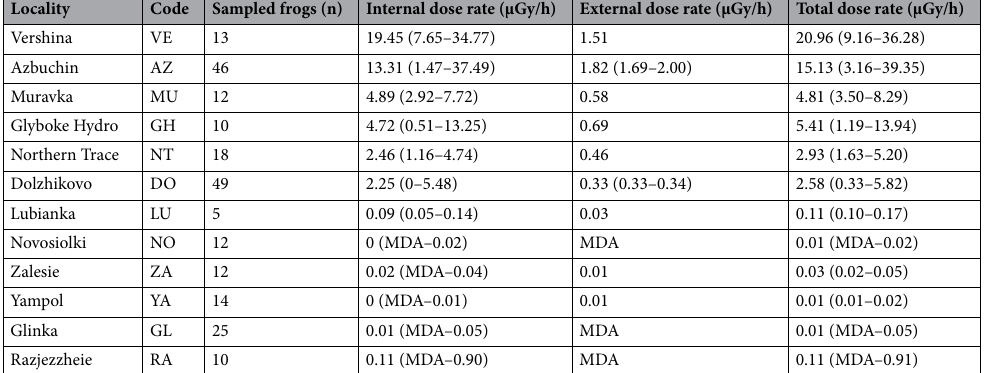
Table 2. Dose rates of breeding Eastern tree frog ( Hyla orientalis ) males captured within the Chernobyl Exclusion Zone (2016–2018). Data presented as mean value (range). Only localities sampled more than 1 year had variation in external dose rates (see text). MDA minimum detectable activity.